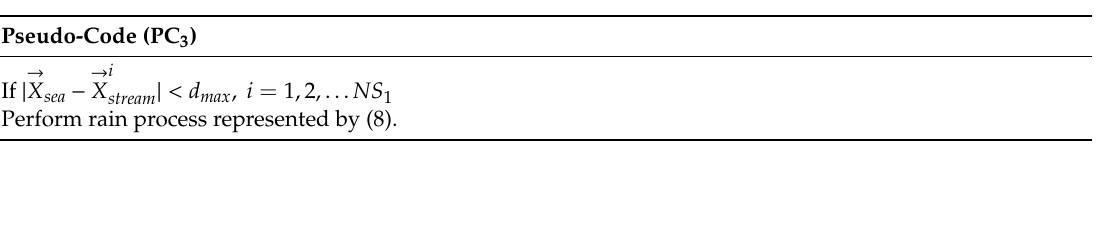
Table 4. Pseudo-code of flow of the stream into the